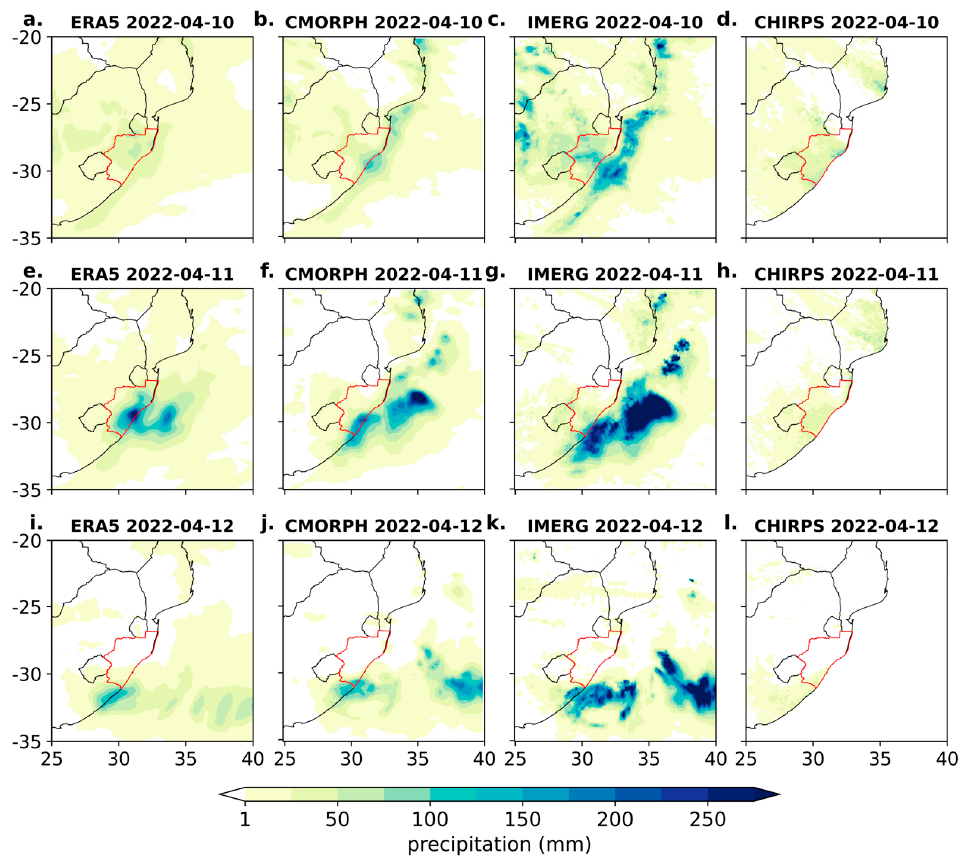
Figure A2. The daily precipitation (shaded; mm) derived from four products, which are ERA5 (panels a , e , i ), CMORPH-CDR ( b , f , j ), IMERG [36] ( c , g , k ) and CHIRPS ( d , h , l ) from 10 to 12 April 2022.